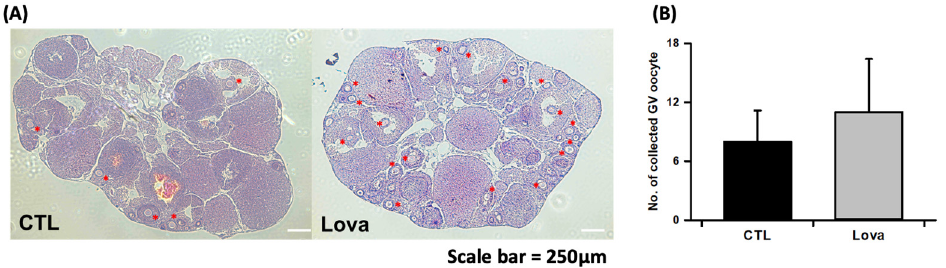
Figure 2. Characterization of lovastatin-treated ovaries. ( A ) Light microscopic images of hematoxylin and eosin-stained mouse ovarian tissue treated without (CTL) and with lovastatin (Lova). Asterisk is primary oocyte and follicles. Scale bar = 250 µ m. ( B ) Number of GV oocytes collected from control and lovastatin-treated ovaries. Data are the mean ± standard error of the mean of four replicates. Control mice ovaries ( n = 30) and Lovastatin-treated mice ovaries ( n = 30). Table 1. Number of oocytes harvested from control and lovastatin-treated oocytes, and in vitro maturation percentages of GV oocytes into GVBD (germinal vesicle breakdown) and MII (metaphase II) phases. Total